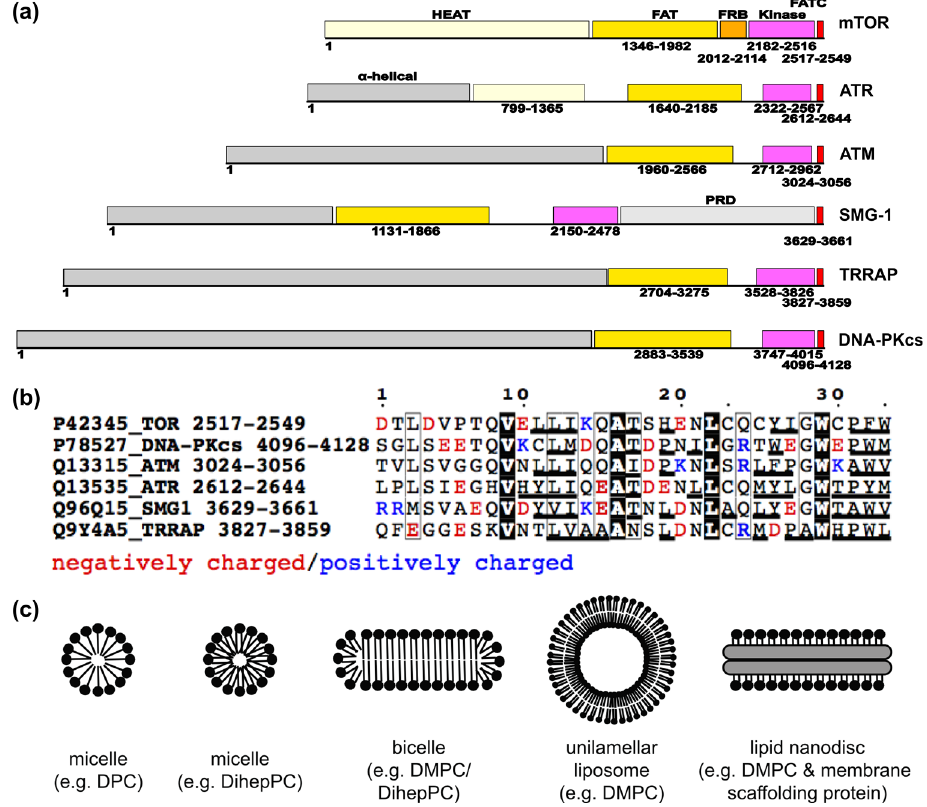
Figure 2. Domain organization of PIKKs, sequence conservation of their FATC domain, and typically employed membrane mimetics. ( a ) The general domain organization of PIKKs, Details are given in the main text; ( b ) sequence alignment of the highly conserved part of the FATC domains (PFAM entry PF02260) of human TOR, DNA-PKcs, ATM, ATR, SMG-1, and TRRAP. The respective Uniprot identification numbers are given at the beginning of each line. Negatively charged residues are colored in red and positively charged ones in